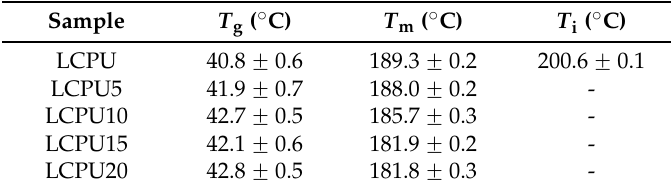
Table 1. Thermotropic properties of LCPU and its composites.